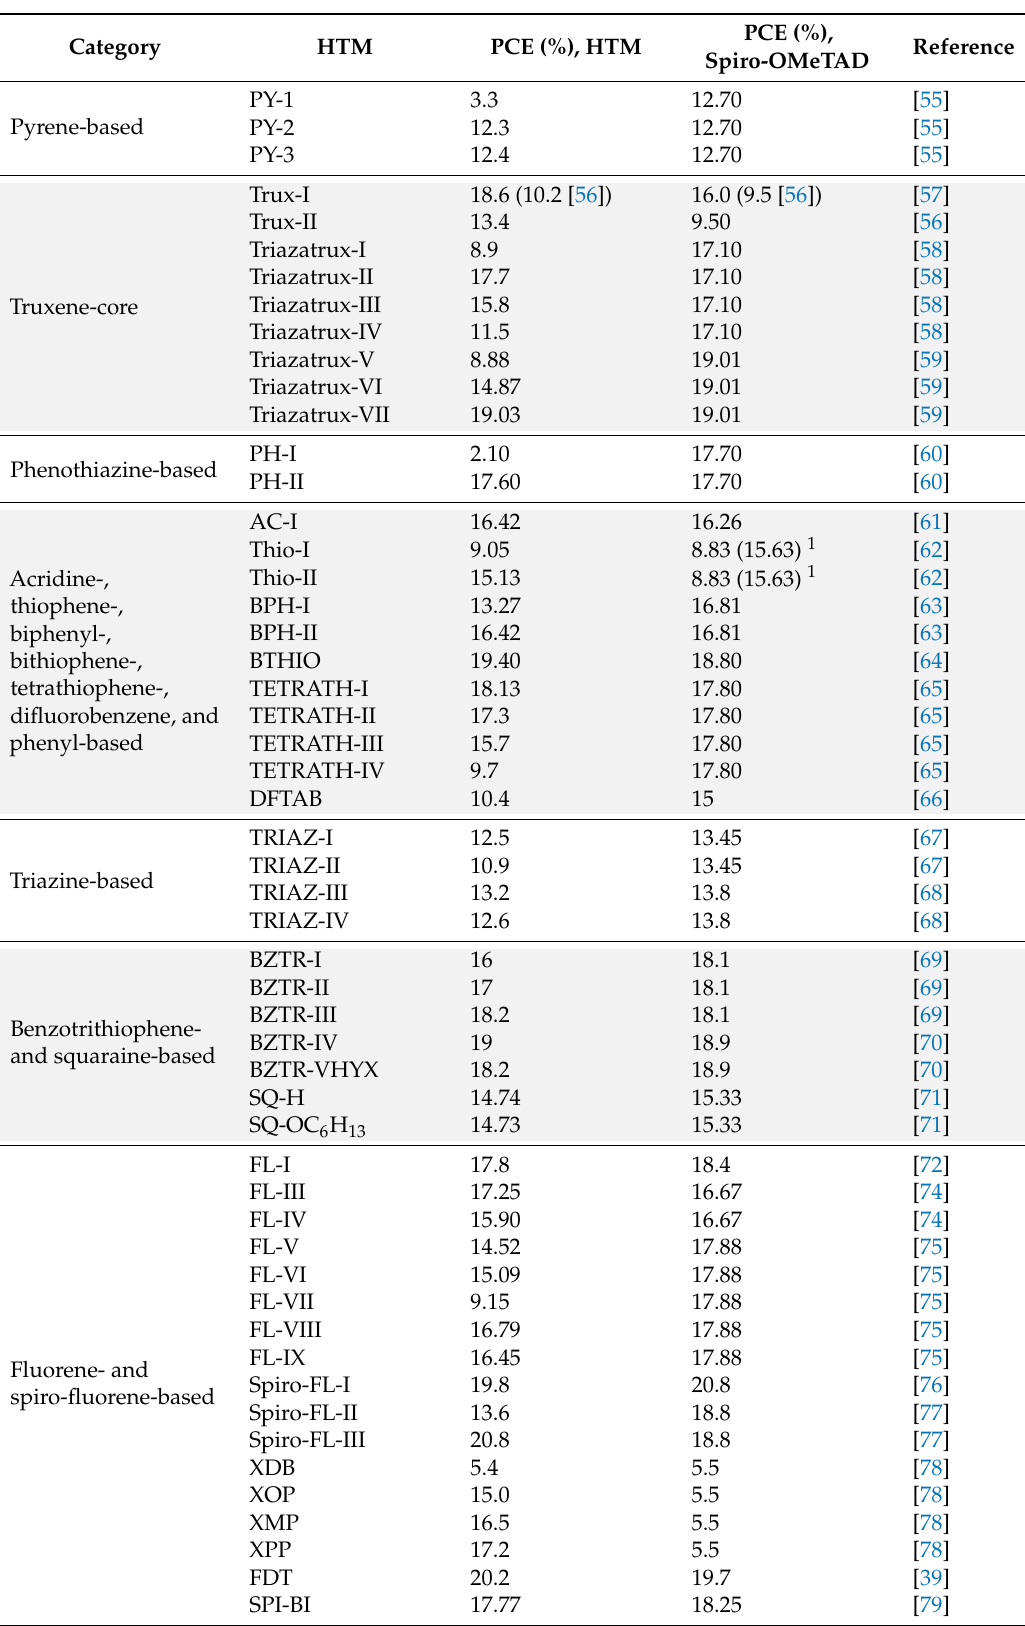
Table 1. Summary of the photovoltaic performance (PCE) for each of the small-molecule HTMs reviewed in this work. For comparison, the PCE of the corresponding reference cells containing spiro-OMeTAD (fabricated and characterized in identical conditions) is also reported. TPA,